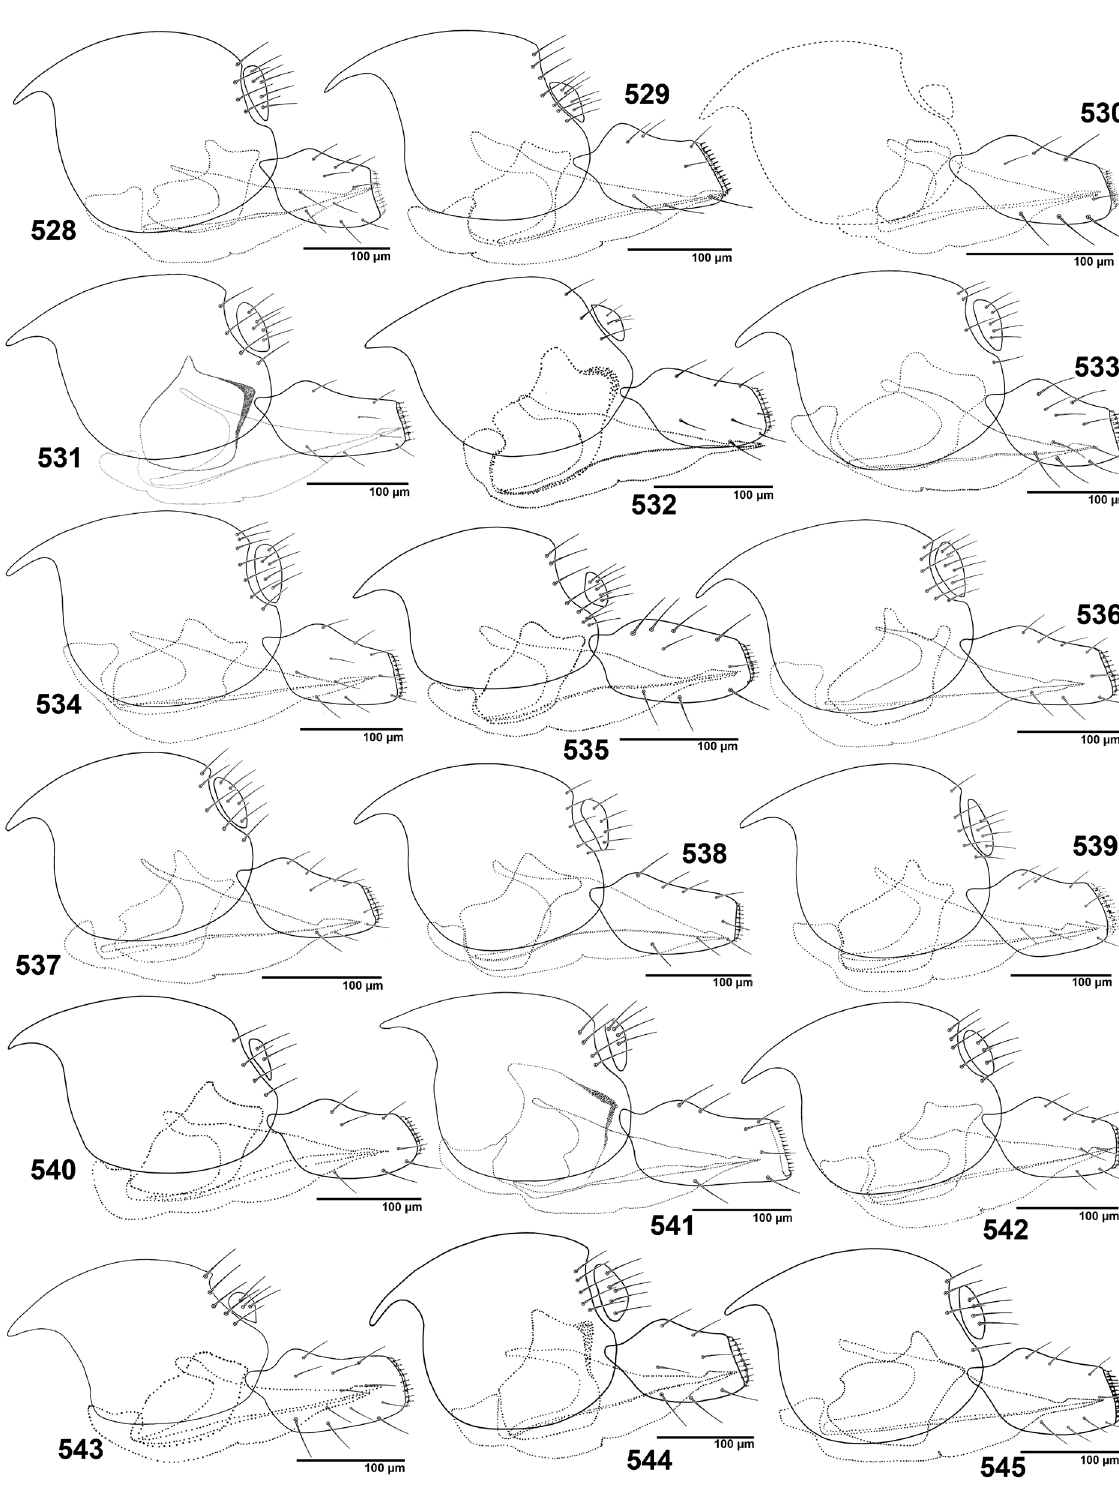
Figs 528–545. Lateral aspect of ♀ genitalia: 528 . Aphidius matricariae . 529 . Aphidius microlophii . 530 . Aphidius myzocallidis . 531 . Aphidius persicus . 532 . Aphidius platensis . 533 . Aphidius popovi . 534 . Aphidius rhopalosiphi . 535 . Aphidius ribis . 536 . Aphidius rosae . 537 . Aphidius salicis . 538 . Aphidius setiger . 539 . Aphidius smithi . 540 . Aphidius sonchi . 541 . Aphidius stigmaticus . 542 . Aphidius transcaspicus . 543 . Aphidius uroleuci . 544 . Aphidius urticae . 545 . Aphidius uzbekistanicus